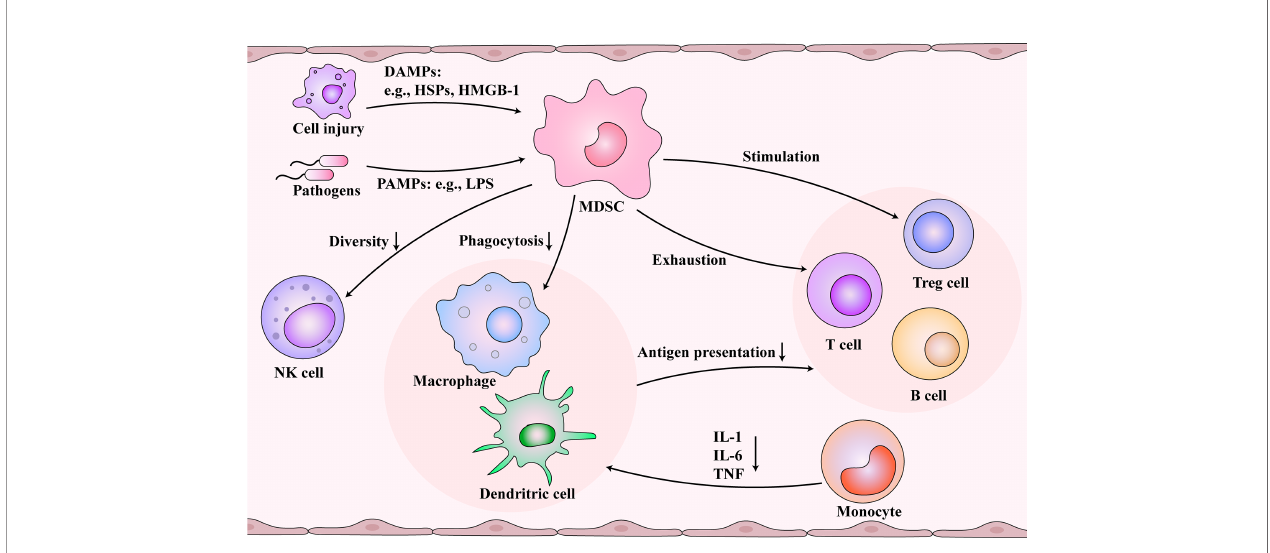
FIGURE 2 | Immunosuppression and immunosenescence caused by myeloid-derived suppressor cells (MDSCs) after sepsis. Damaged cells and pathogens release damage-associated molecular patterns (DAMPs) and pathogen-associated molecular patterns (PAMPs), respectively, which are picked up by the immune system. During immunosuppression and immunosenescence stage of sepsis, MDSCs are activated and inhibit the function of dendritic cells (DCs) and macrophages. At the same time, MDSCs reduce the diversity of NK cells. Monocytes differentiate into DCs and macrophages, but MDSCs change the cytokines secreted by them. The functions of the T cells and B cells are inhibited by damaged antigen-presenting cells, controlled by MDSCs, and regulated by regulatory T (Treg) cells. Immunosenescence and immunosuppression form a vicious